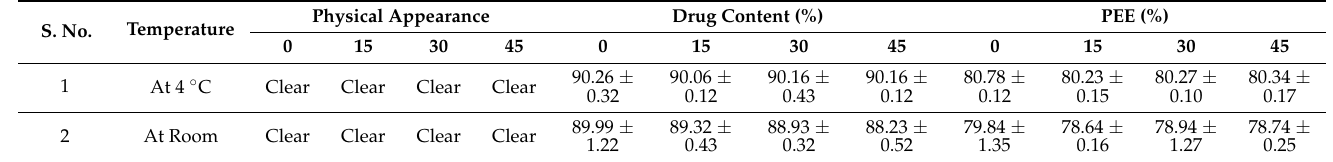
Table 4. Stability studies of formulation-optimized transferosome-loaded